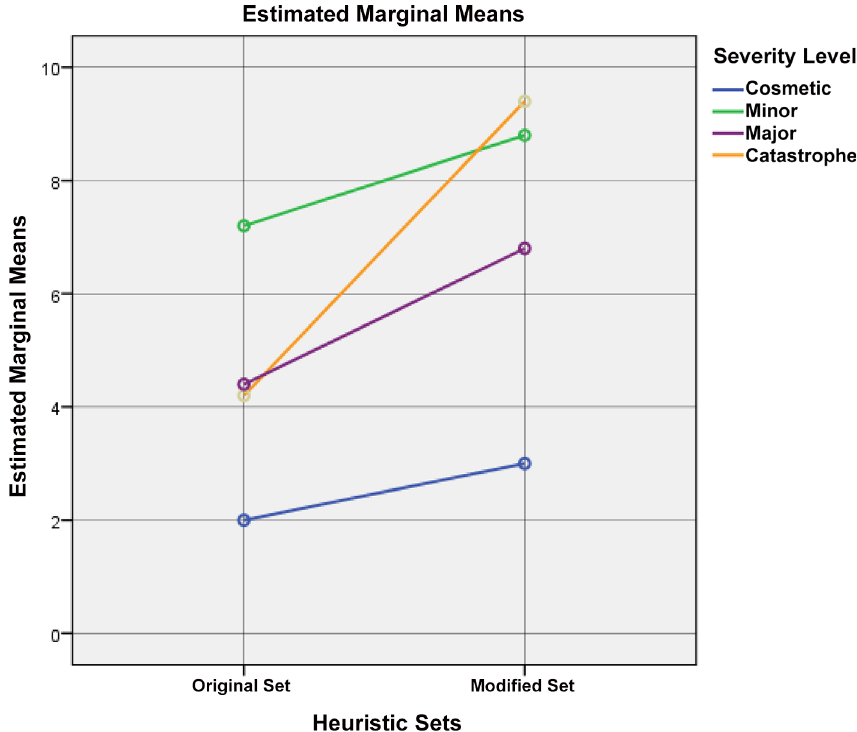
Fig 8. Estimated marginal means of problem identification by both sets of